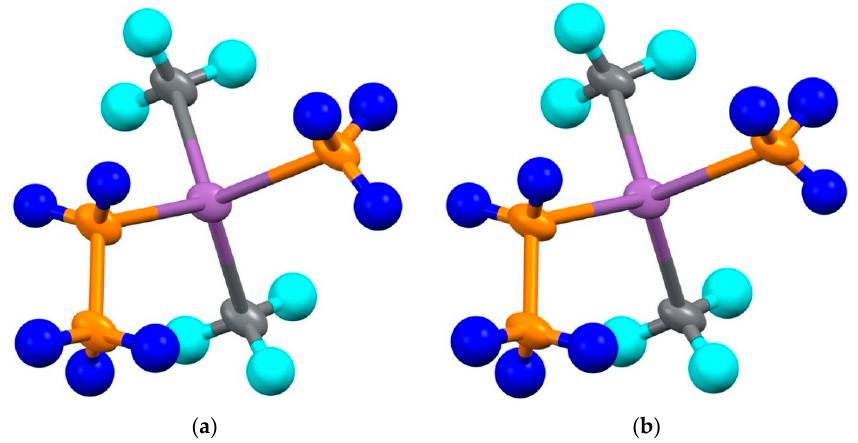
Figure 3. Average structure of the cation at 5 K viewed from the b axis (the two-fold axis) for two different cooling rates: ( a ) Rapid cooling ( − 120 K/h); and ( b ) slow cooling ( − 0.6 K/h).